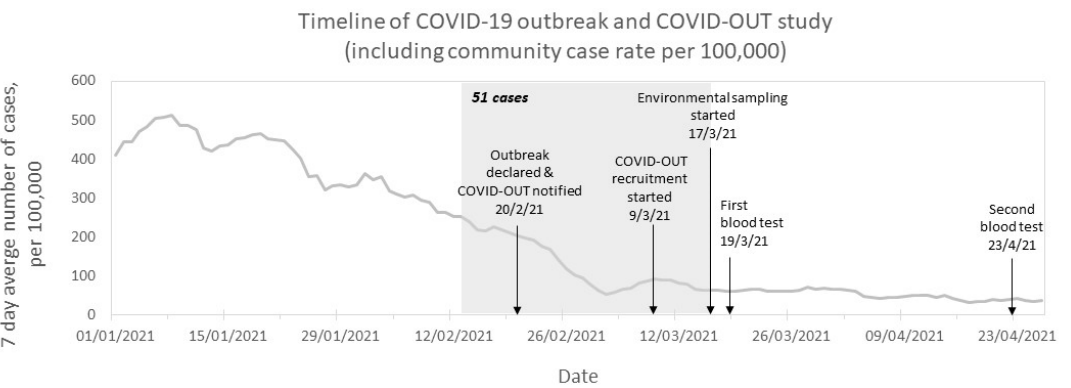
Figure 1. Timeline and epidemiological curve of COVID-19 outbreak investigation in a UK automotive manufacturing site between 13 February 2021 and 23 April 2021. Arrows indicate key dates of the outbreak and COVID-OUT study. The grey box indicates the period of time during which 51 acute SARS-CoV-2 infections were reported by the company. The line chart represents the 7-day case rate for the lower tier local authority area (LTLA) of the site (contains public sector information licensed under the Open Government Licence v3.0 from [10]; the date of download: 18 August 2021).